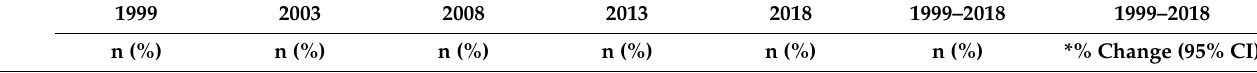
Table 2. Distribution of other-unskilled-birth-attendant deliveries by study factors in Nigeria,